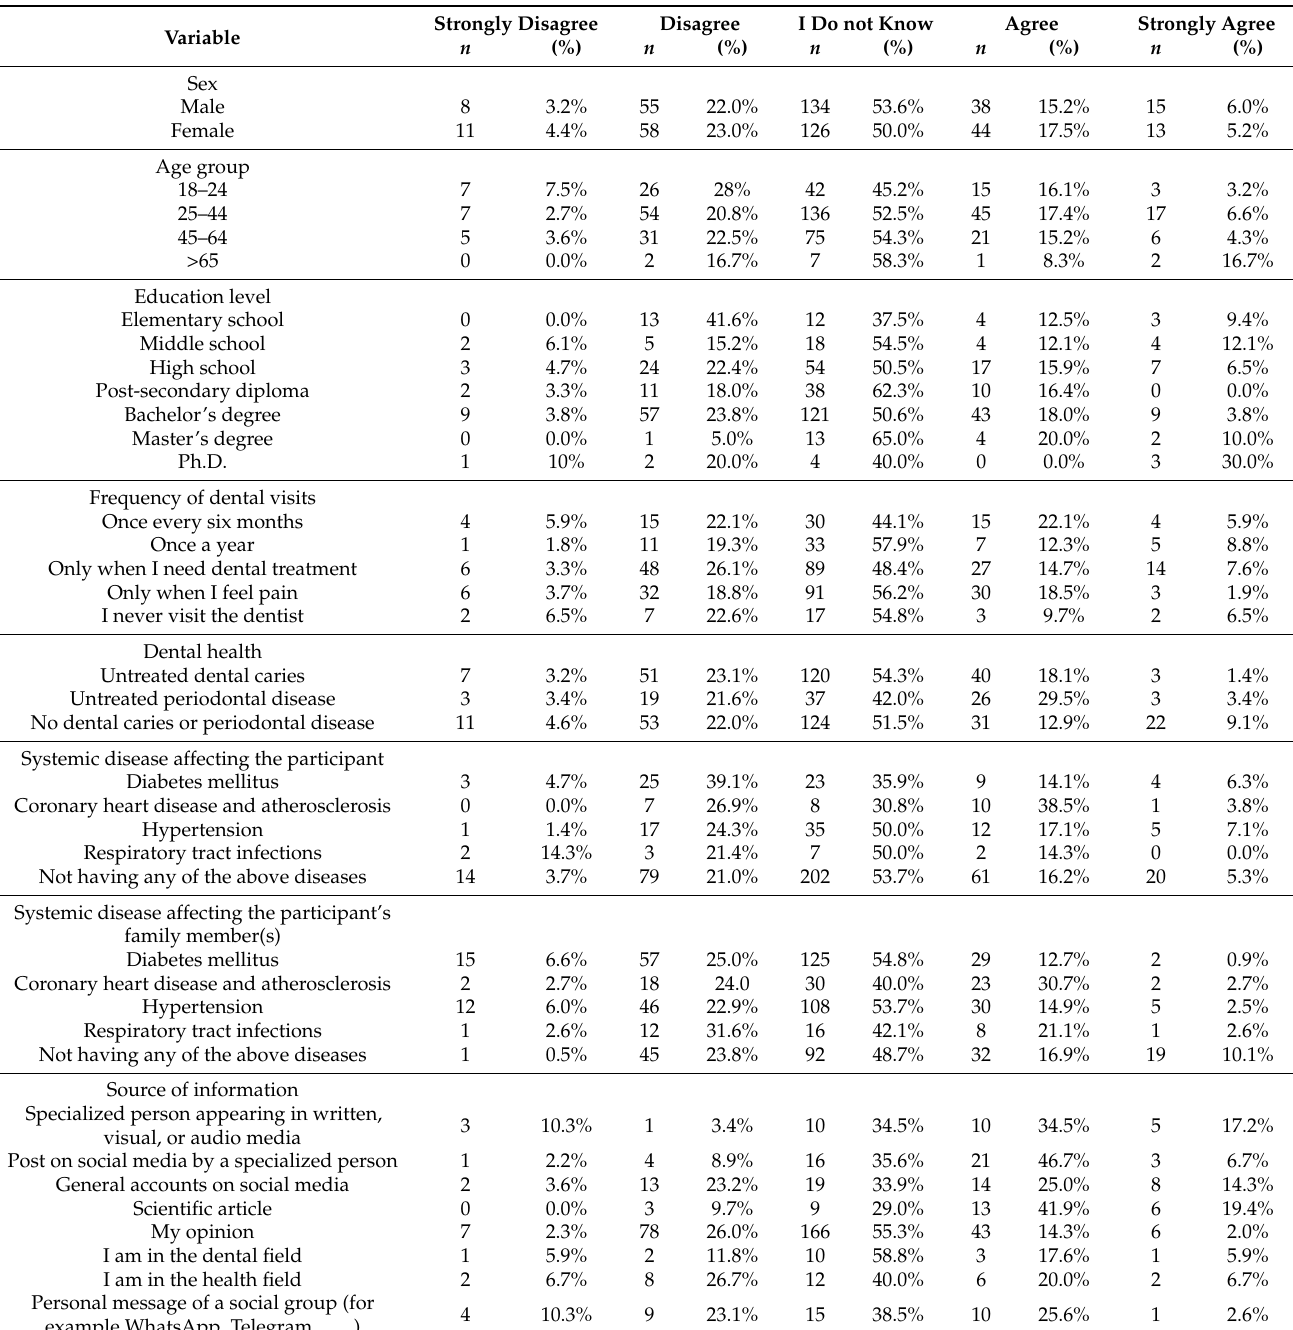
Table 8. Awareness about the association between periodontal disease and coronary heart disease and atherosclerosis distributed by various